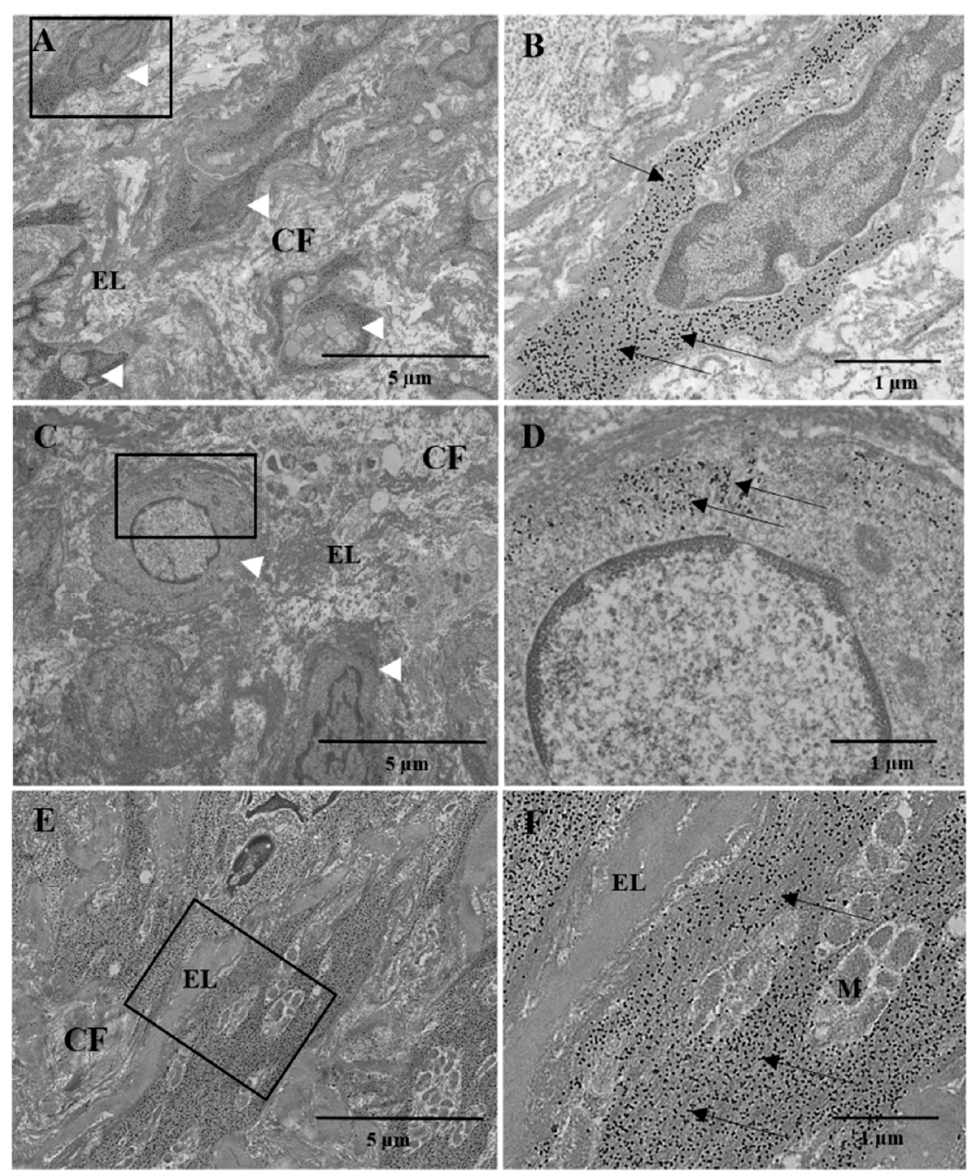
Figure 8. ( A ) Tunica media of the PAG 69 days after implantation. Smooth muscle cells of regular and oriented shape (arrowheads) were interspersed with elastic fibers and collagen; ( B ) close-up of ( A ) (black box) in which the cytoplasmic α -actin filaments of a smooth muscle cell were detected by 10 nm colloidal gold particles (arrows). ( C ) Intimal hyperplasia of PAG: elastic and collagen fibers appeared disoriented, and many smooth muscle cells (arrowheads) showed an immature appearance; ( D ) close-up of ( C ) (black box). Smooth muscle cell with a large nucleus and few contractile filaments close to the cytoplasmic membrane (arrows). ( E ) SOG aorta tunica media. Smooth muscle cells appeared regularly orientated and commixed with elastic fibers and collagen bundles. ( F ) Close-up of ( E ) (black box). Smooth muscle cells showed typical α -actin filaments in cytoplasm (arrows). CF: collagen fibers; EL: elastic fibers; M: mitochondria. ( A – F ) Post-embedding immunogold α -SMA labeling. ( A , C , E ) 3000×, original magnification; ( B , D , F ) 10,000×, original magnification.